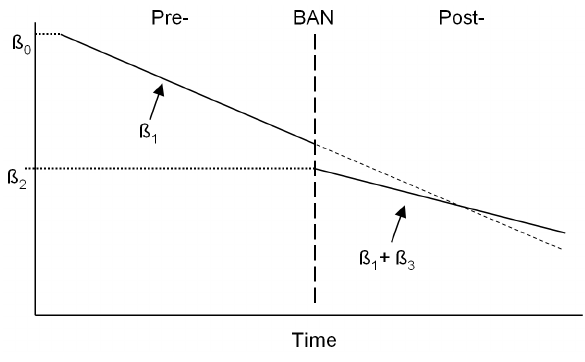
Figure 1. Interpretation of model results. The Y axis represents weekly mortality, the X axis represents Time, and the bold line represents the monotonic mortality change pre- and post-ban. The vertical interrupted line represents the time of the smoking ban policy implementation.